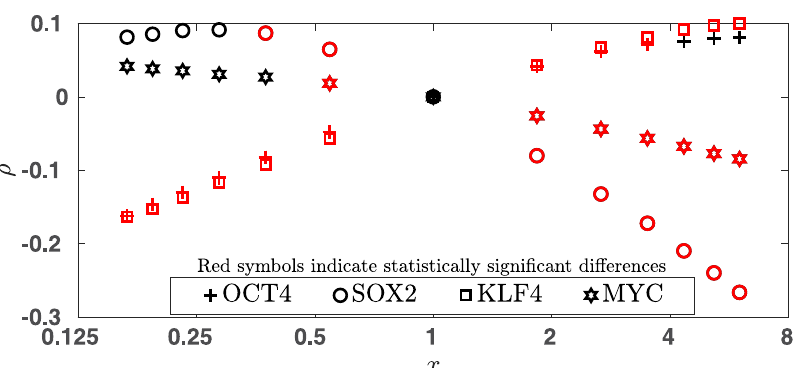
Fig 1. Effect of stoichiometry. For different stoichiometric ratios (O:S:K:M) ρ ( x ), defined in Eq 10, are plotted. Here x is the relative decrease or increase in the level of one of the RFs while those of the rest of the RFs remain unchanged. A positive (negative) ρ is suggestive of a higher/lower IP